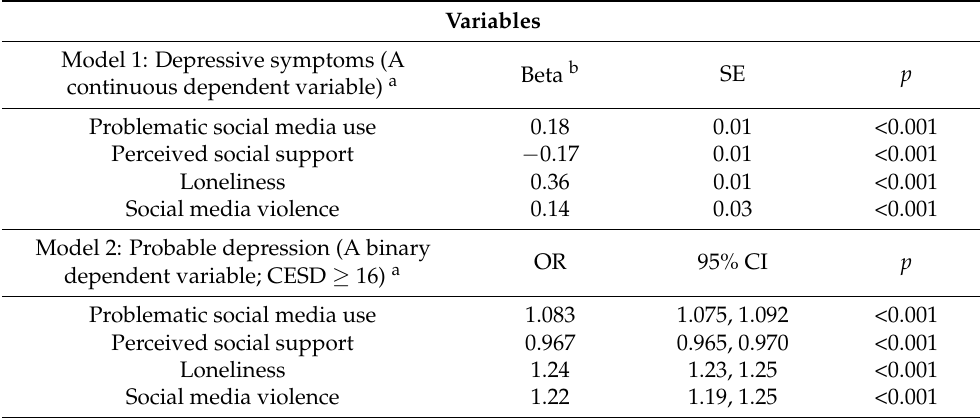
Table 3. Adjusted associations between scores on social media addiction, perceived social sup- port, loneliness, and social media violence with depressive outcomes among college students in Shaanxi,